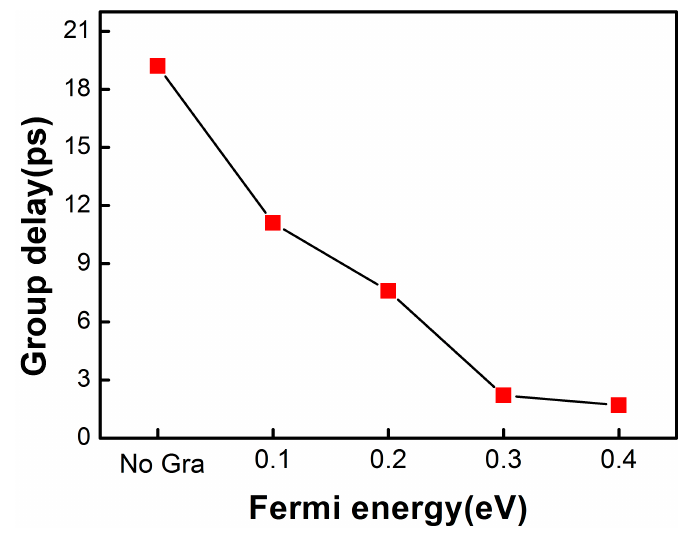
Figure 7. The maximum group delay with the PIT window versus Fermi energy of graphene.